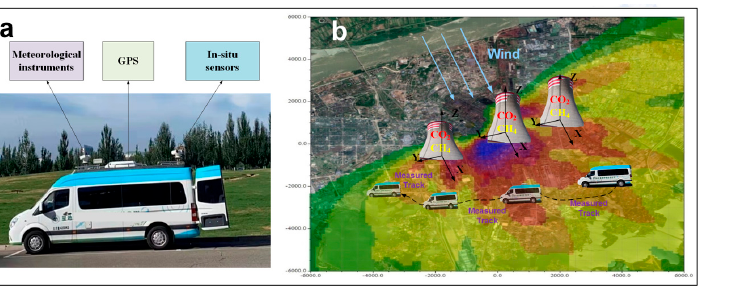
Figure 6. OCO-2 measurements.